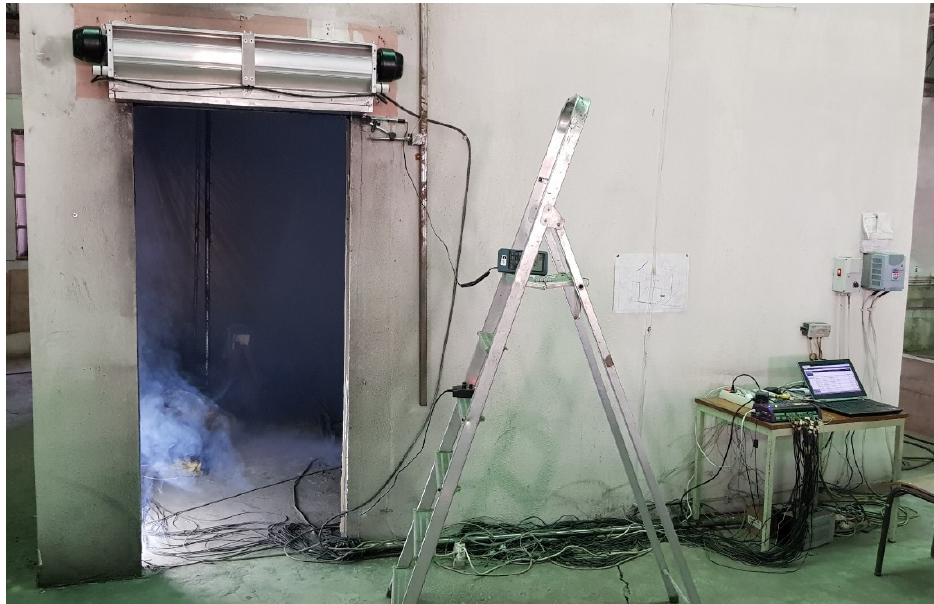
Figure 4. General view of the test compartment.